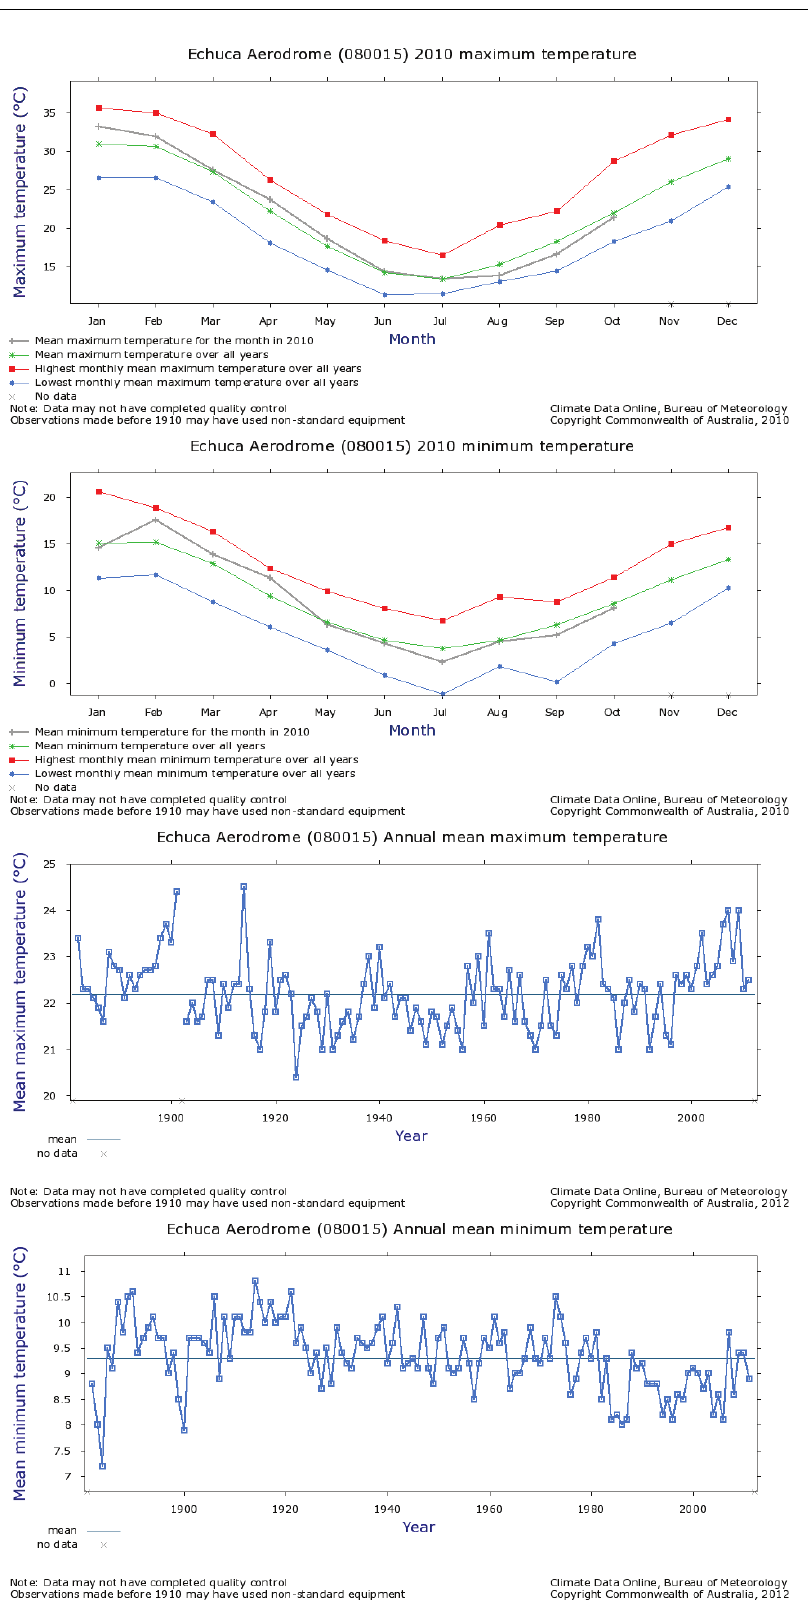
Figure 20. Australian Government Bureau of Meteorology temperature graphs for historical locations in Victoria, Aus-